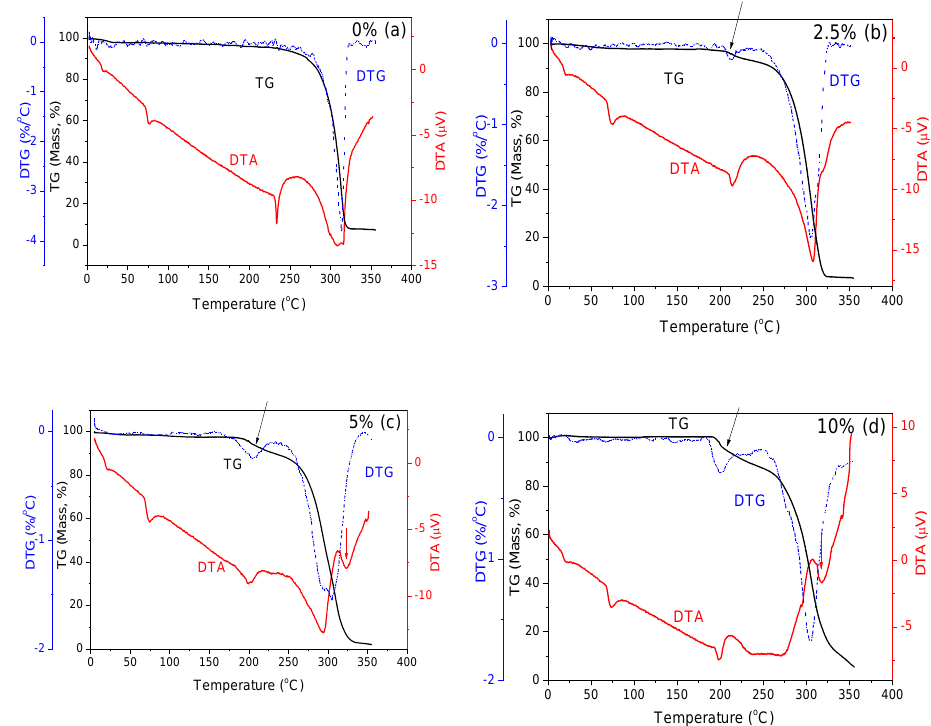
Figure 5. TG, DTG, and DTA curves of ( a ) TBA-PF 6 with Al 2 O 3 additive at concentration of ( b ) 2.5, ( c ) 5, and ( d ) 10 wt %.